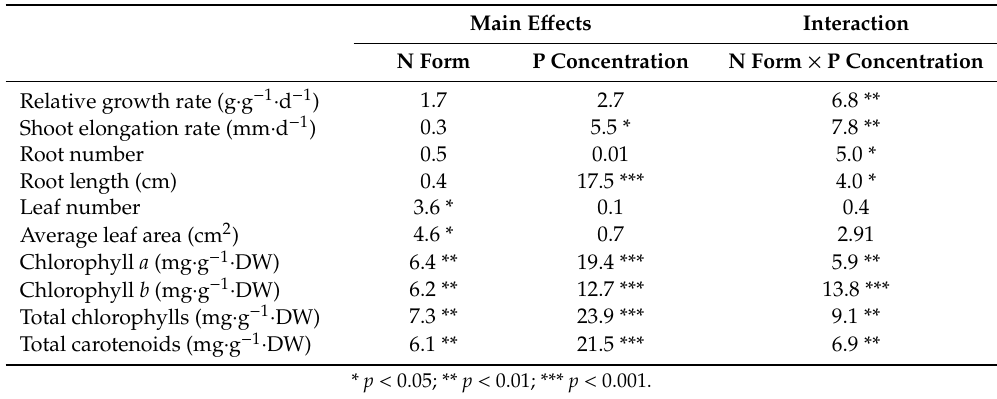
Table 1. Results of two-way ANOVA (F-ratios) of growth, morphological characteristics, chlorophylls and carotenoids concentrations in leaves of hybrid Napier grass ( Pennisetum purpureum × Pennisetum americanum ) grown on different nitrogen (N) forms (NH 4+ , NO 3 − , or NH 4 NO 3 ) and phosphorus (P) concentrations (100 and 500 µM).